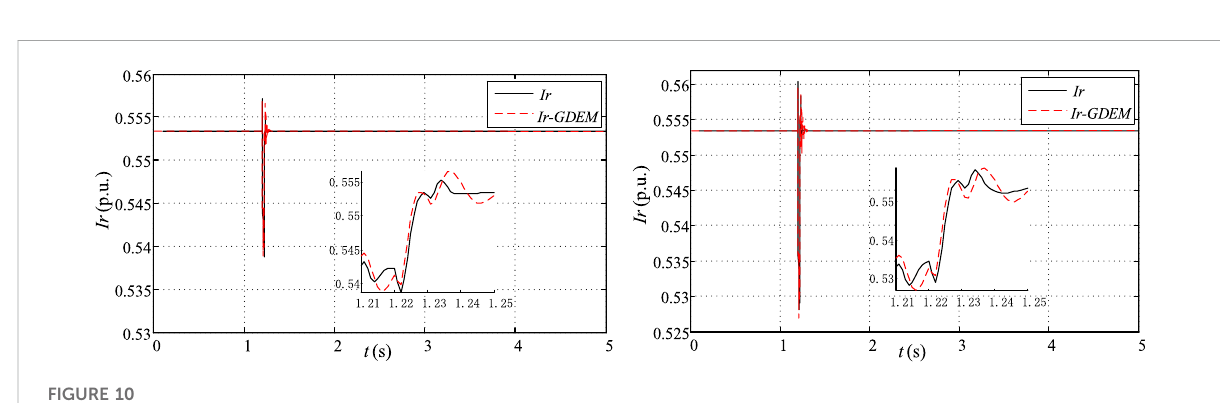
Dynamic characteristic response of the real part of the current with F11 and F12 in operating condition